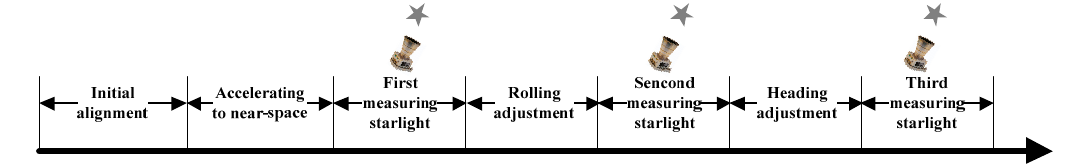
Figure 2. Simulation procedure. Table 1. The estimated value of installation errors in Case 1 (unit: arc-seconds).